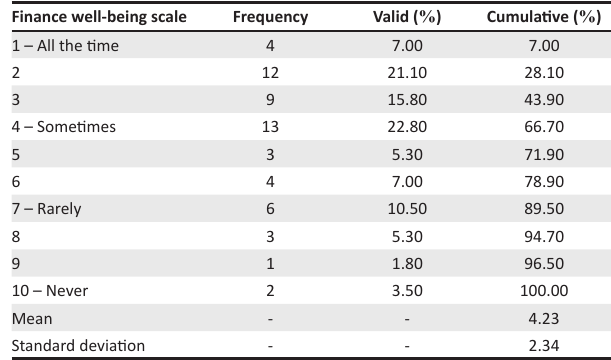
TABLE 7: How frequently do you find yourself just getting by financially and living from paycheck to paycheck?